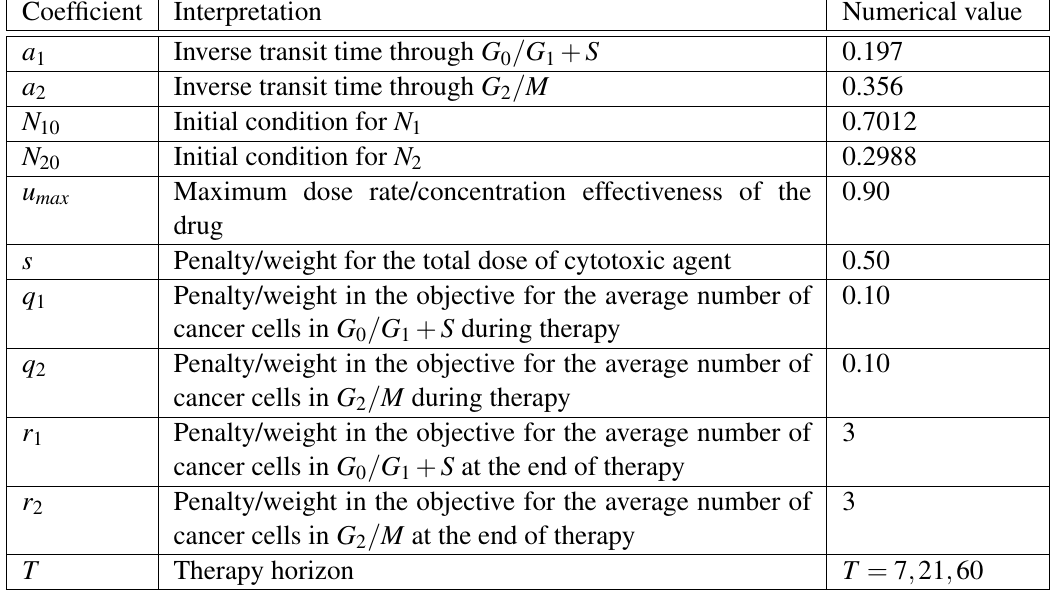
Table 1 Numerical values for the coefficients and parameters used in numerical computations for the optimal control problem 1, extracted from